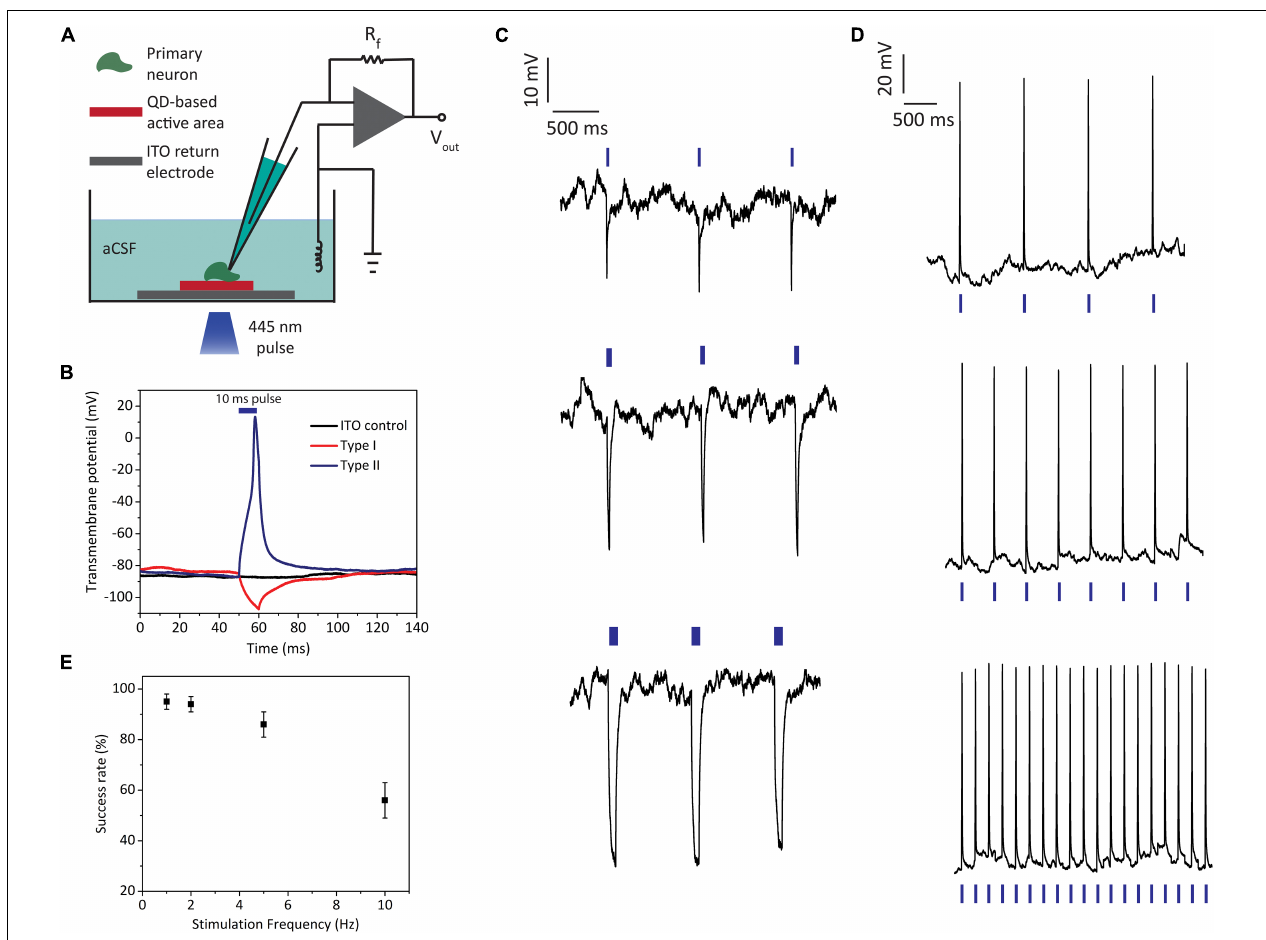
FIGURE 5 | Light-induced electrophysiology recordings of primary hippocampal neurons cultured on biointerfaces. (A) Schematic of the single cell electrophysiology setup. (B) Transmembrane potential recordings of neurons on type I, type II, and ITO control samples (illumination: blue LED at 445 nm, 10 ms pulse width, 2 mW mm − 2 optical power density; blue bar indicates the 10 ms “light on” interval). (C) Neural membrane recordings of hippocampal neurons on type I biointerfaces for 1 Hz stimulus with different pulse widths (top: 10 ms, middle: 50 ms, bottom: 200 ms) (illumination: blue LED at 455 nm, 2 mW mm − 2 optical power density; blue bars indicate the “light on” intervals). (D) Neural membrane recordings of hippocampal neurons on type II biointerfaces for 1, 2, and 5 Hz stimulus (the membrane response to 10 Hz stimulus is shown in Supplementary Figure 7 ) (illumination: blue LED at 445 nm, 10 ms pulse width, 2 mW mm − 2 optical power density; blue bars indicate the “light on” intervals). (E) Success rate of action potential firing for type II biointerfaces for 1, 2, 5, and 10 Hz stimulus frequencies (Mean ± SD, for N =